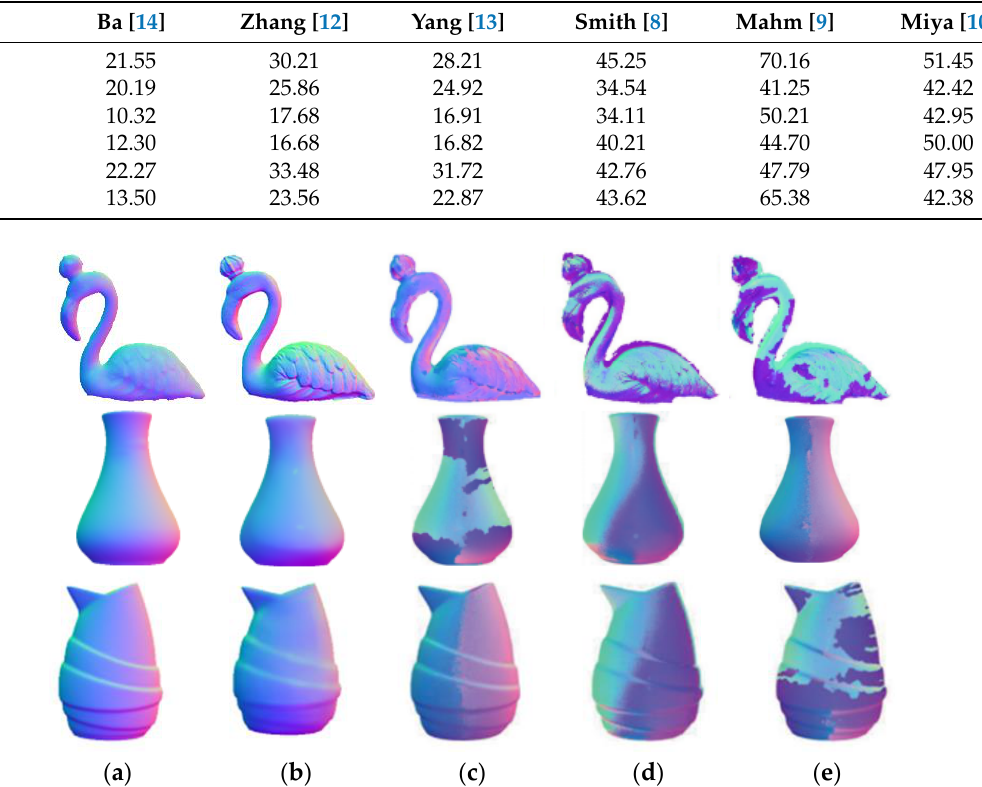
Table 1. Comparison index of normal vector fusion algorithm.